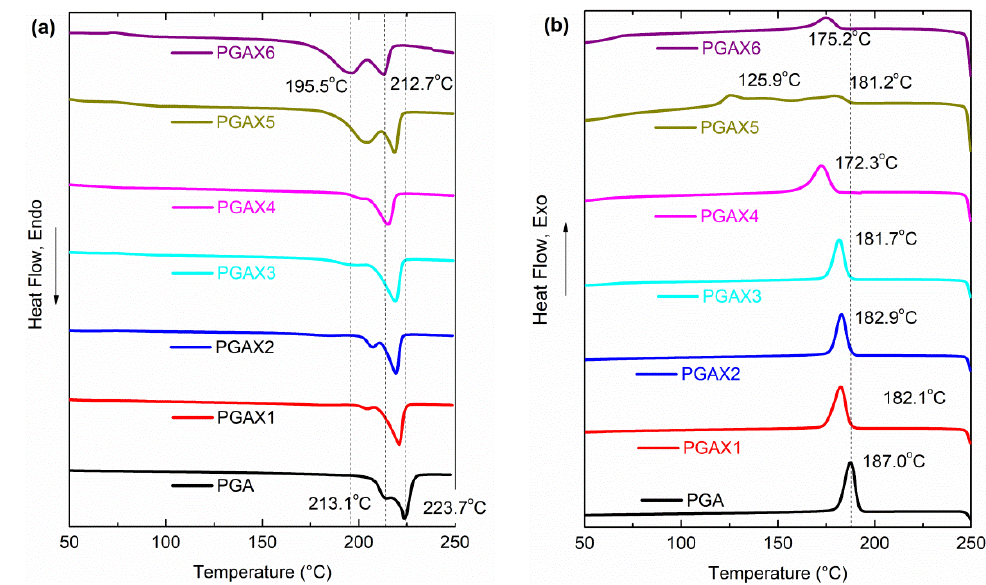
Figure 2. DSC patterns of PGA and PGAX: ( a ) DSC heating curves and ( b ) DSC cooling curves.